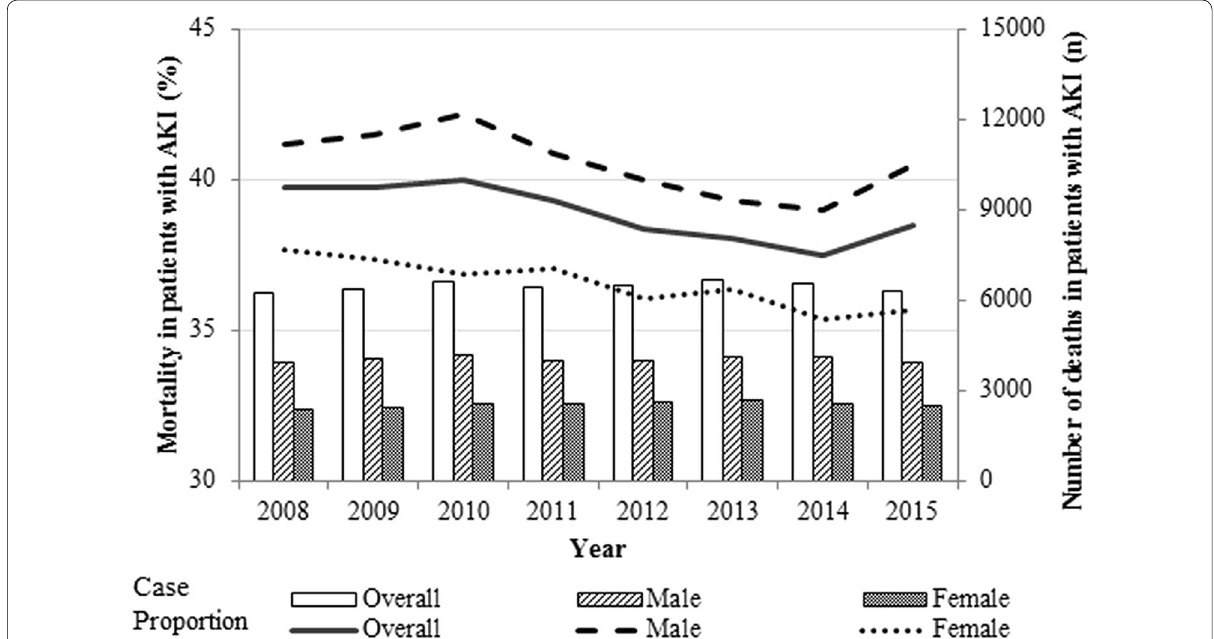
Fig. 2 In-hospital mortality rate in critically ill patients with acute kidney injury in Korea between 2008 and 2015. Bars represent absolute number of deaths in critically ill patients with acute kidney injury (AKI); lines represent mortality of critically ill patients with AKI. Mortality decreased from 39.1 to 37.2% ( p for trend <